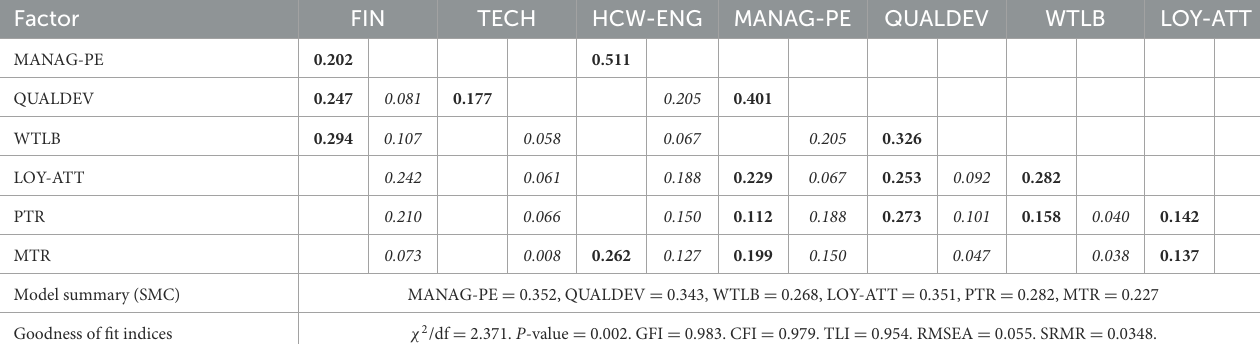
Bold,standardizeddirecteffect;Italic,standardizedindirecteffect;emptycells,neitherdirectnorindirecteffect. MANAG-PE, management performance evaluation; HCW-ENG, health care workers’ engagement; FIN, financial incentives; QUALDEV, quality and development; TECH, technology; WTLB, workload time-life balance; LOY-ATT, loyalty attitudes; MTR, HCWs trusting their managers; PTR, perceived patient respect and trust attitudes toward health care workers; SMC, squared multiple correlations; χ 2 /df, minimum discrepancy divided by its degrees of freedom; GFI, goodness-of-fit index; CFI, comparative fit index; TLI, Tucker–Lewis’s index; RMSEA, root mean square error of approximation;SRMR,standardizedrootmeansquareresidual.